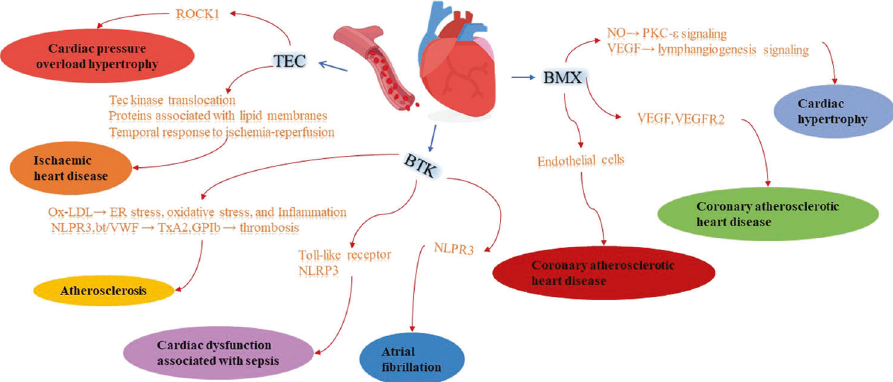
Fig. 1 The regulation and functions of Tec family kinases in cardiac and vascular disease. Ox-LDL oxidized low-density lipoprotein, ROCK1 Rho kinase 1, ER endoplasmic reticulum, bt/VWF botrocetin/von Willebrand factor-mediated, TXA2 thromboxane A2, GPIb glycoprotein Ib, VEGF Vascular endothelial growth factor, VEGFR2 VEGF receptor 2, PKC- ε protein kinase C - ε domain [15], which are characteristic of Tec kinases. The PH STRUCTURAL FEATURES OF TEC FAMILY KINASES domain binds to phospholipids to mediate membrane association Tec kinases have a highly conserved carboxy-terminal kinase (the PH domain recruits Tec kinases to the cell membrane by domain and a relatively long and unique amino-terminal domain binding certain phospholipids) [16], but the PH domain of Txk is (Fig. 2). The amino-terminal domain can be further divided into a replaced by a cysteine motif, which mediates membrane pleckstrin homology (PH) domain [14] and a Tec homology (TH)